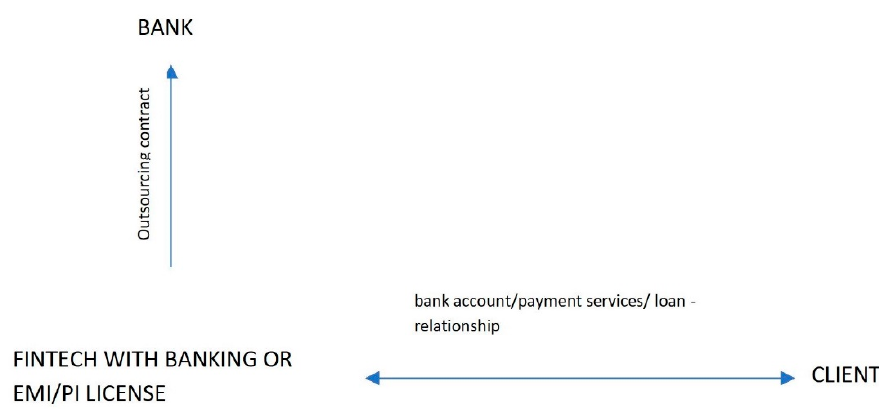
Figure 2. Bank acting as an outsourcing services provider.